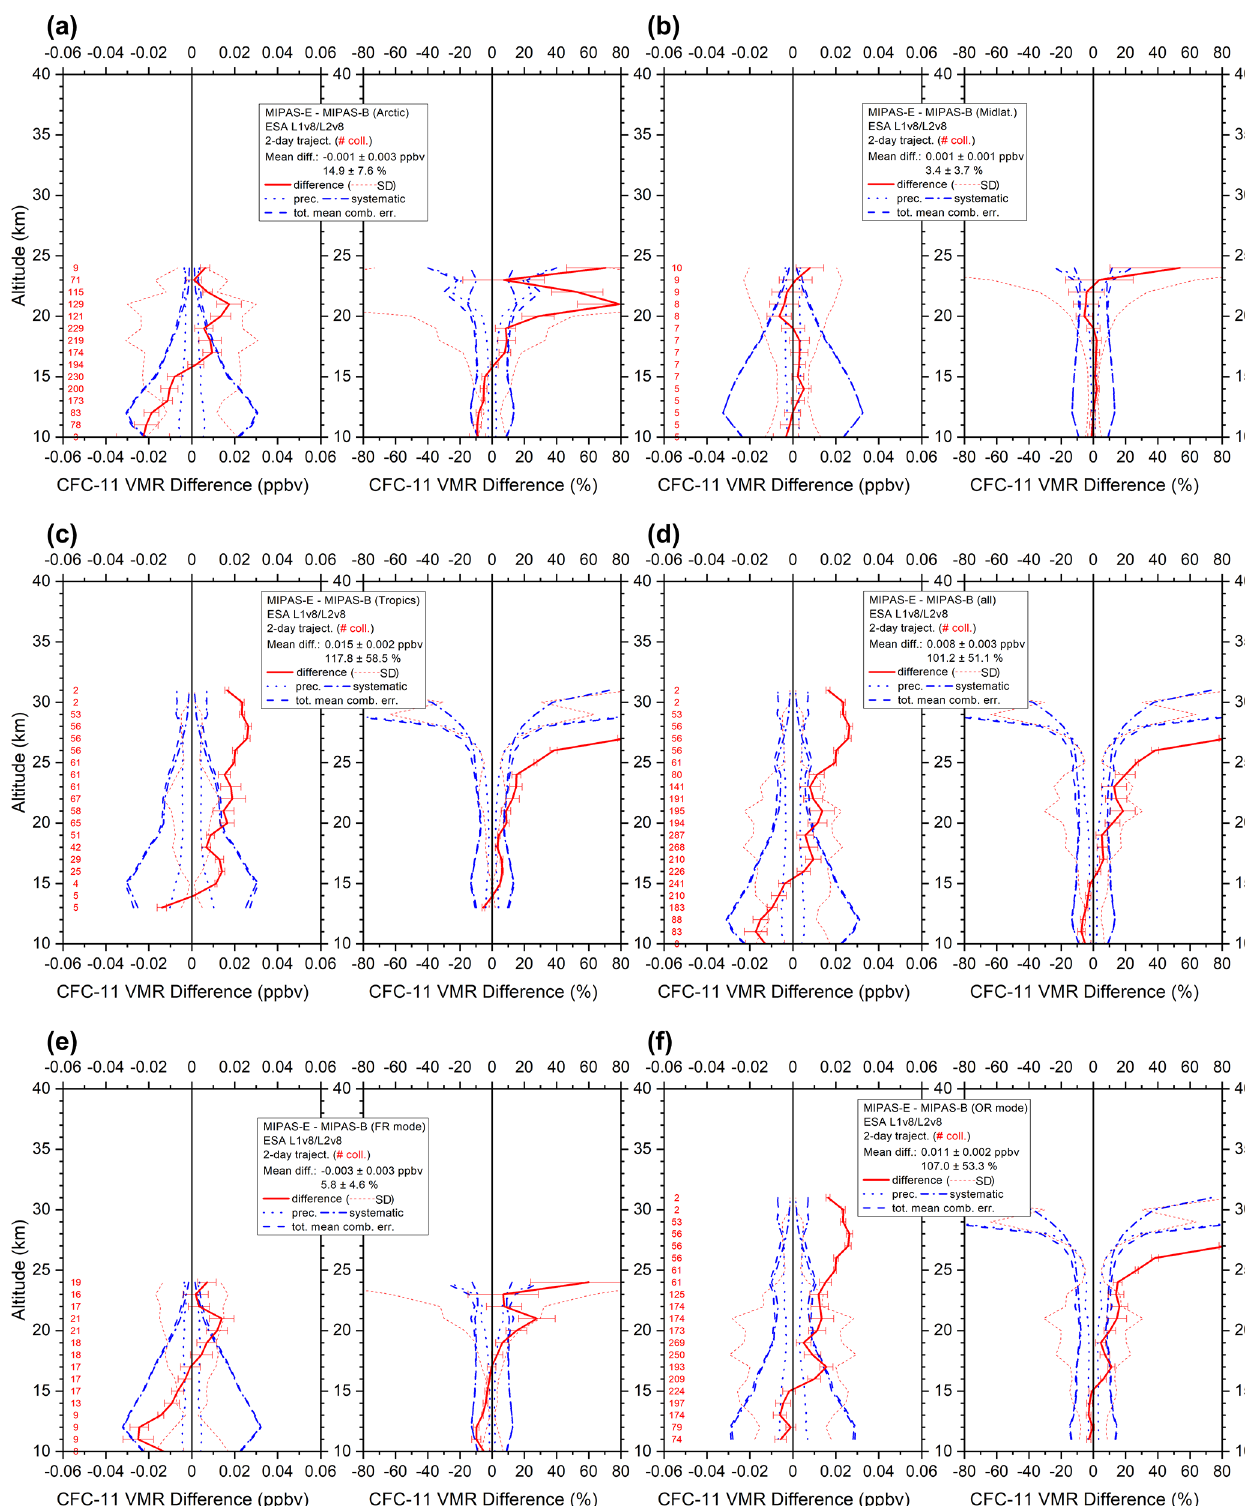
Figure 11. Same as Fig. 3 but for